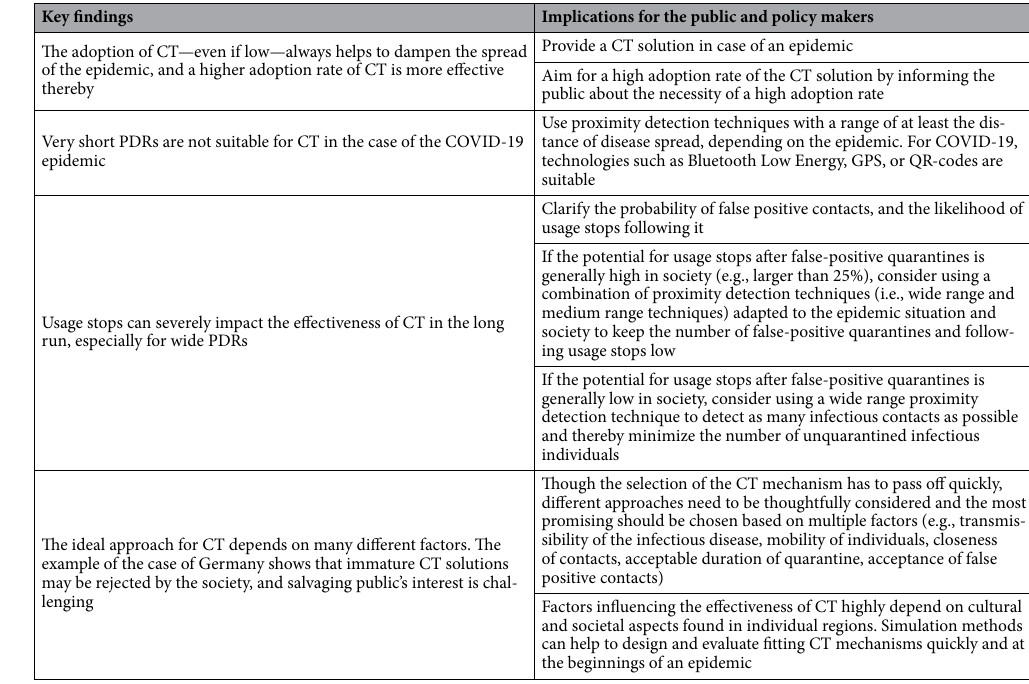
Table 3. Key findings and implications for the public and policy makers of our